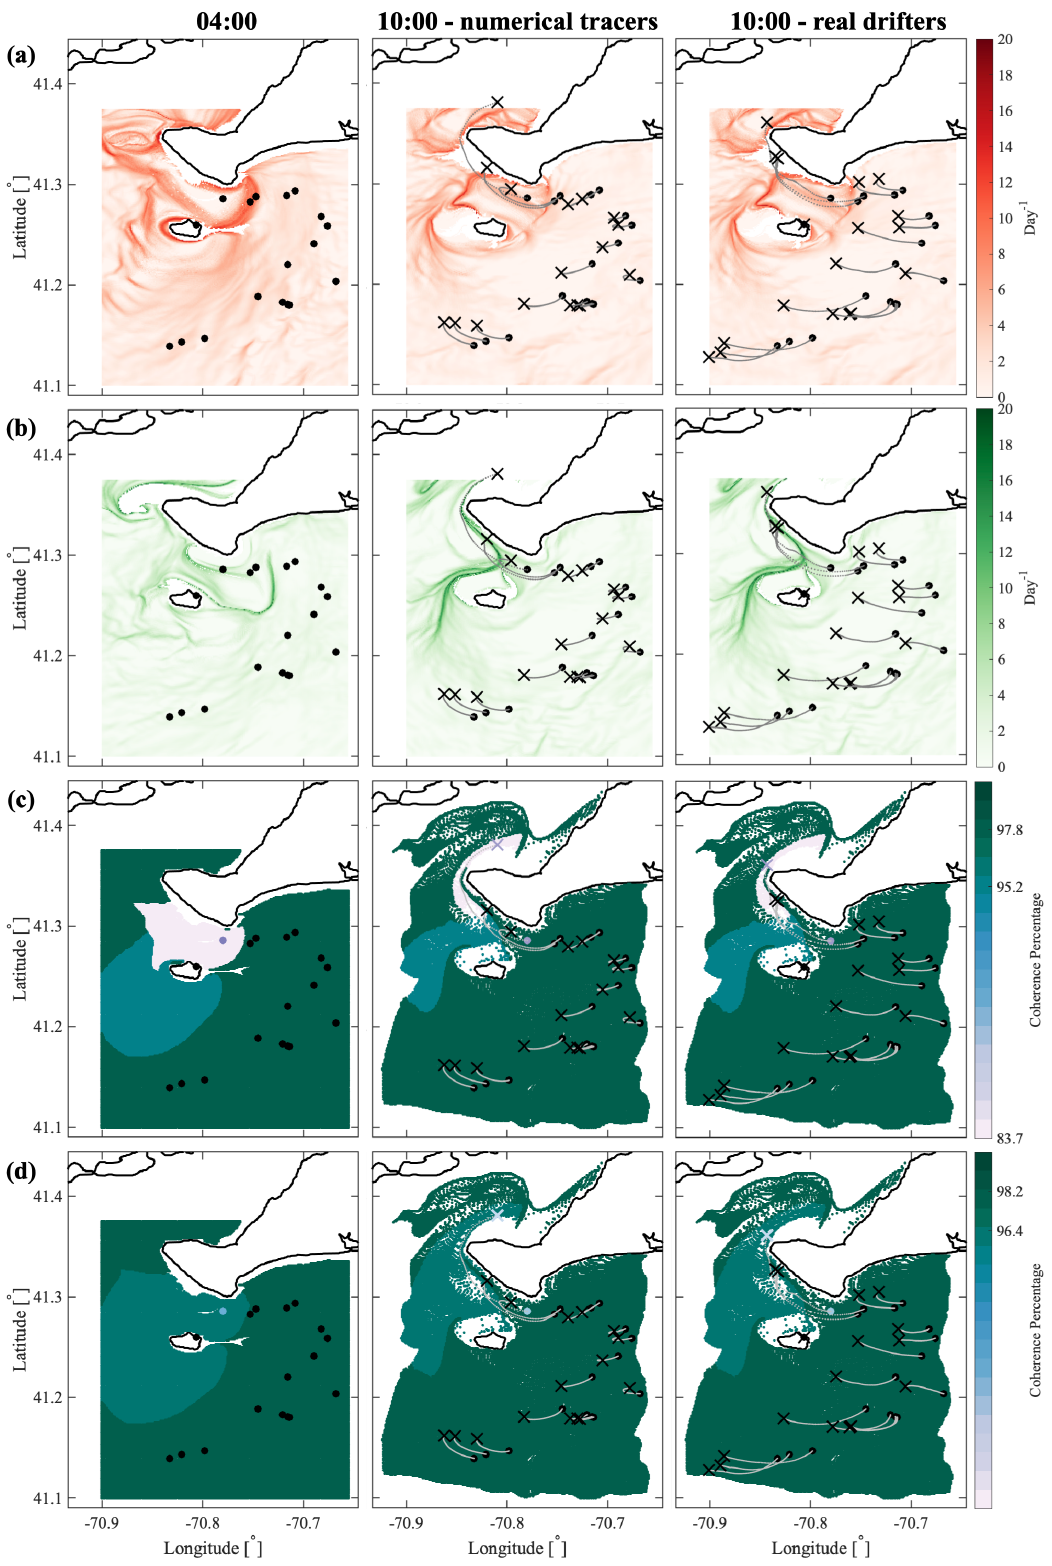
Figure 10. LCS, numerical tracers and drifter positions at the start (04:00 UTC) and end (10:00 UTC) of the 2018 experiment on August 8. ( a ) Forward and ( b ) backward FTLE. ( c , d ) Spectral clusters with coherence metric. The drifters are color-coded according to the cluster to which they belong, with red crosses if their final positions were outside their initial